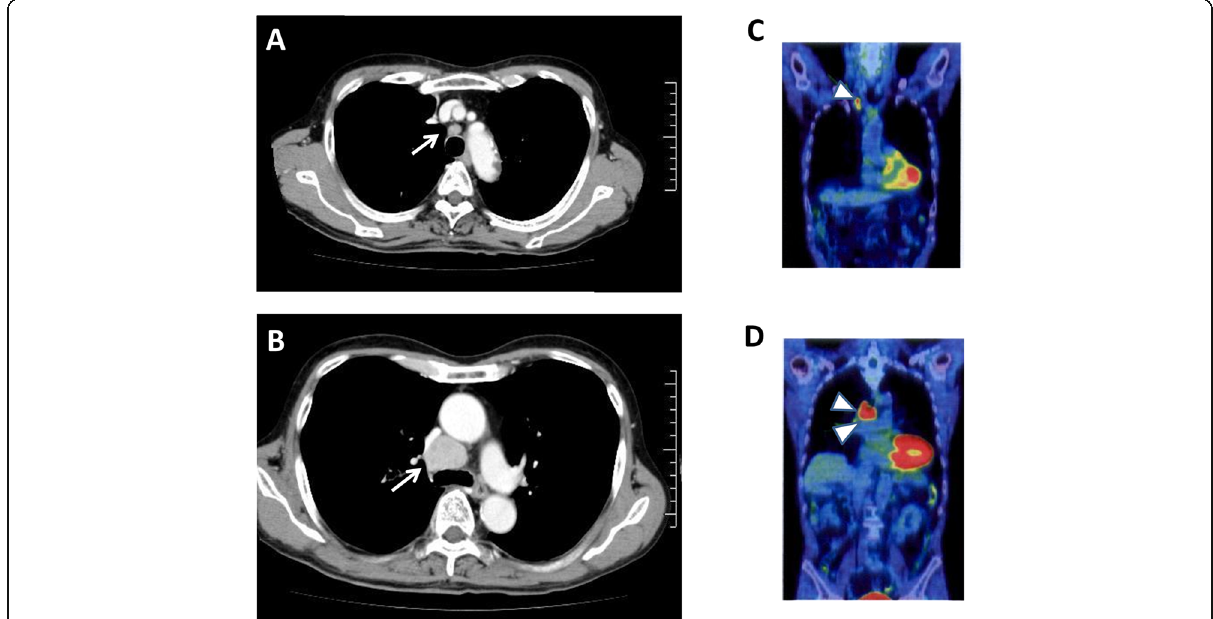
Fig. 1 Enhanced computed tomography revealed swelling of the right upper paratracheal lymph node ( a , arrow ) and right lower paratracheal lymph node ( b , arrow ). Abnormally high uptake in the right supraclavicular lymph node ( c , arrowhead ) and right lower paratracheal lymph node ( d , arrowheads ) was detected by positron emission tomography/computed tomography. The right lower paratracheal lymph node was the main lesion, which was approximately 2.7 cm in size. The right upper paratracheal lymph node and right supraclavicular lymph node were